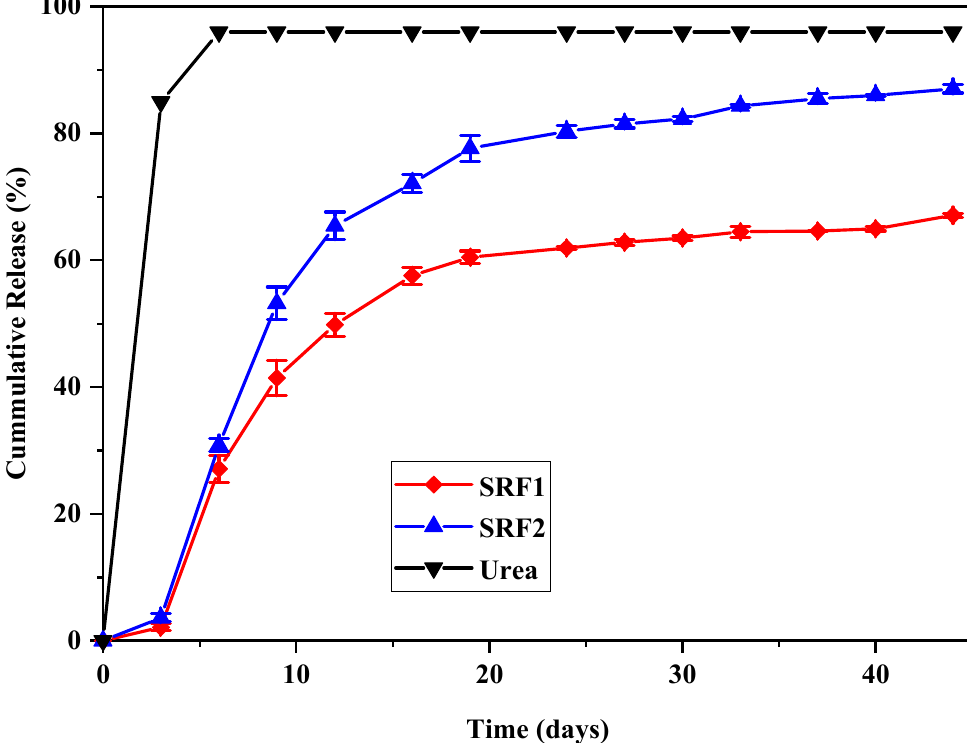
Figure 8. Kinetic parameters of each of the model used.